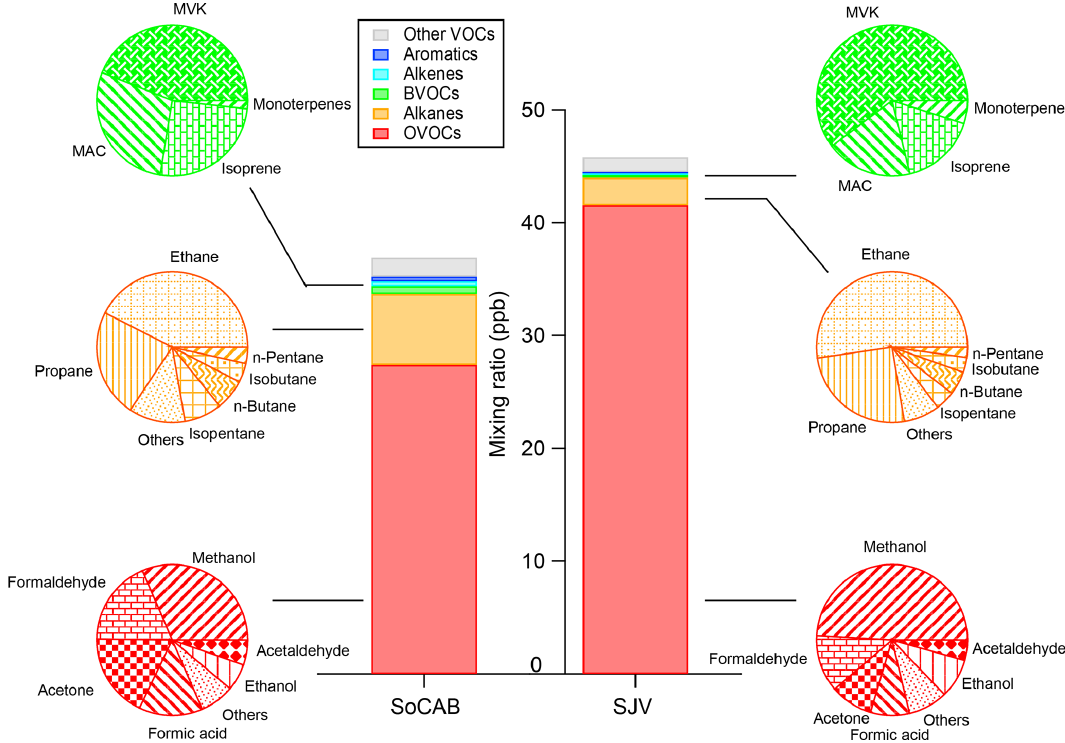
Figure 2. The campaign-averaged VOC composition for the SoCAB and SJV.